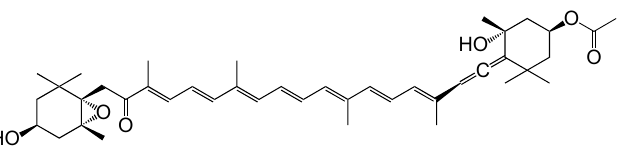
Figure 1. Molecular structure of fucoxanthin (Fx). Molecular weight, 658.91.